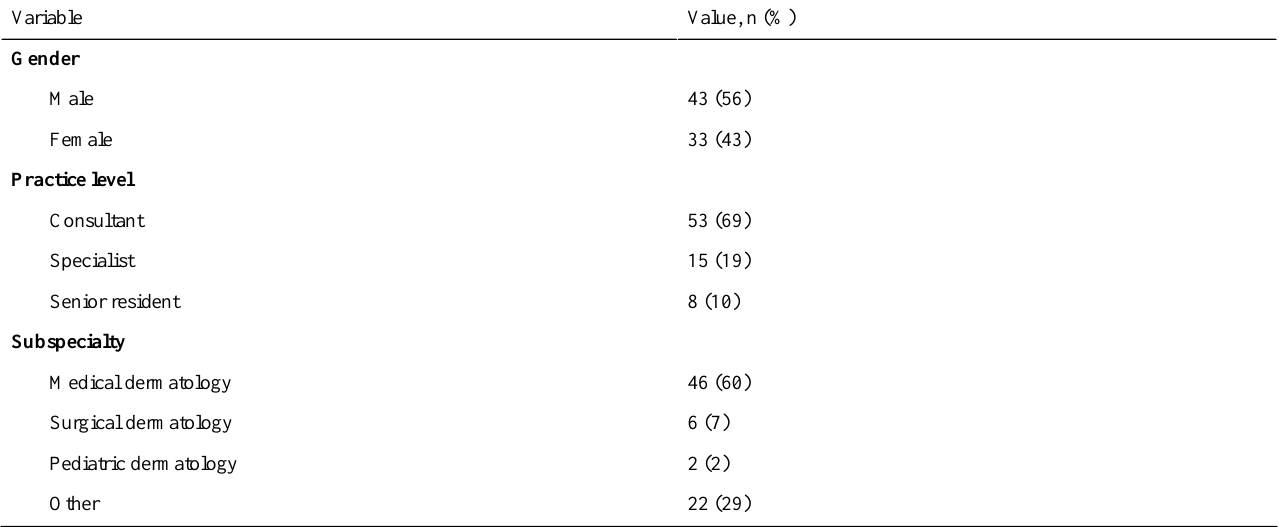
Table 1. Demographic